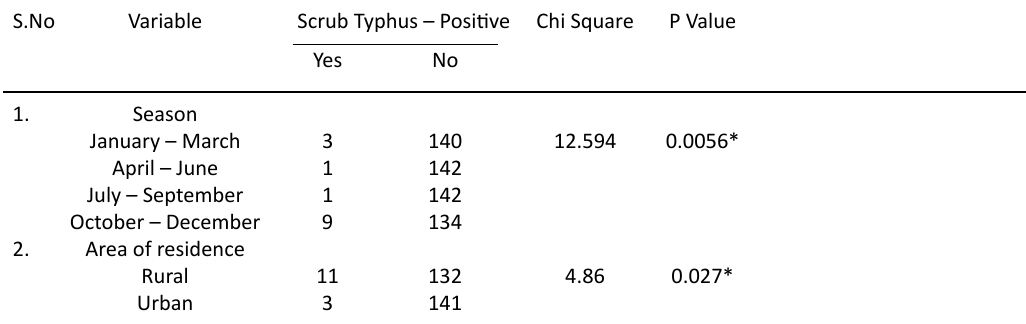
*P – value < 0.05. Statistically significant at 95% Confidence